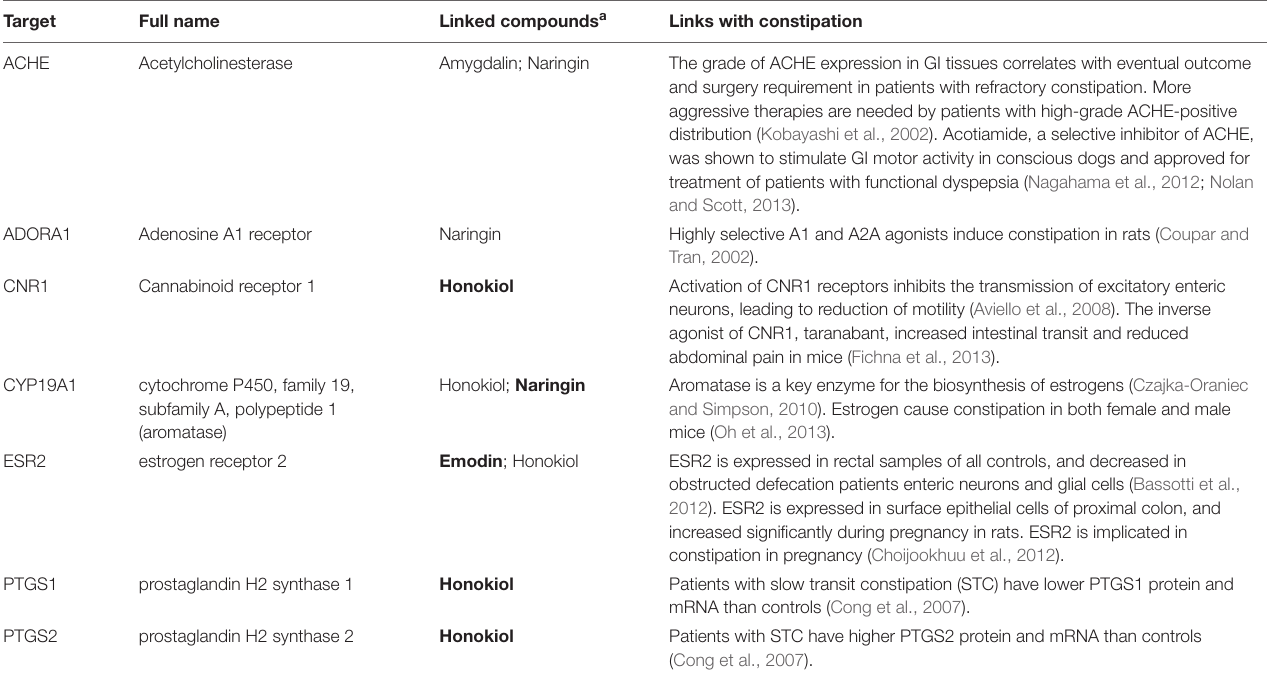
TABLE 2 | Referenced and predicted targets correlated with